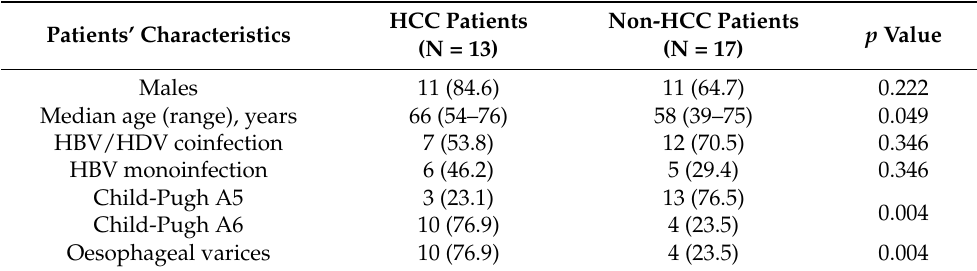
Table 2. Characteristics of hepatocellular carcinoma (HCC) and non-HCC patients.